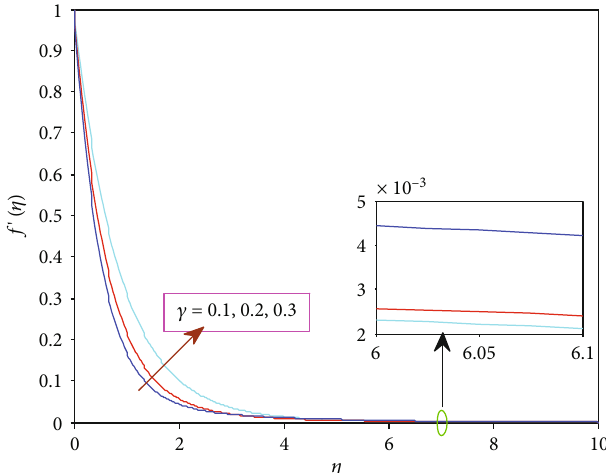
Figure 2: Velocity distribution for di ff erent values of the couple stress parameter.